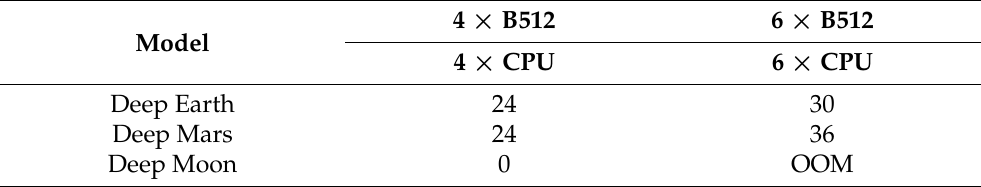
Table 15. Multi-Stream benchmark results (max number of streams) for B512 DPU architecture.